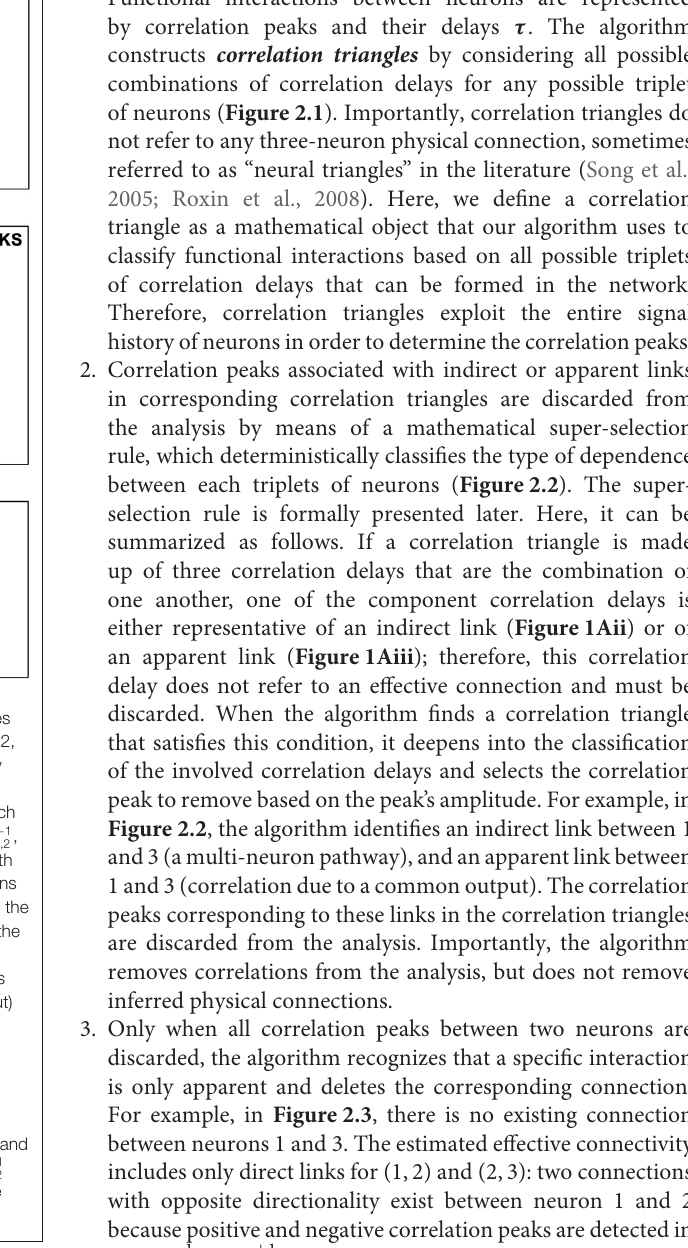
can occur in time between the three pairs of neurons. These correspond to the eight correlation triangles shown on the right side of the panel. (2) Among the correlation triangles, the algorithm detects 2 critical cases ( | τ − 1 1,2 + τ − 2 2,3 + τ + 1 3,1 | < ǫ and | τ + 1 1,2 + τ − 1 2,3 + τ + 2 3,1 | < ǫ ) and identifies the peaks relative to an indirect (multi-neurons path) and an apparent (common output) connection by searching for the ones with smaller amplitude. The smallest peaks ( τ + 1 3,1 and τ + 2 3,1 ) are discarded from the analysis. (3) The correlation triangles are functional to the estimation of the direct connections in the network. Because no more correlation exists between neuron 1 and 3 , the estimated effective connectivity includes only the direct links for (1,2) and (3,1): two connections with opposite directionality exist between neuron 1 and 2 because positive and negative correlation peaks are detected in R 1,2 ( τ − 1 1,2 and τ + 1 1,2 ); one link connects neuron 2 to neuron 3 as a result of the positive correlation peaks in R 2,3 ( τ + 1 3,1 and τ + 2 3,1